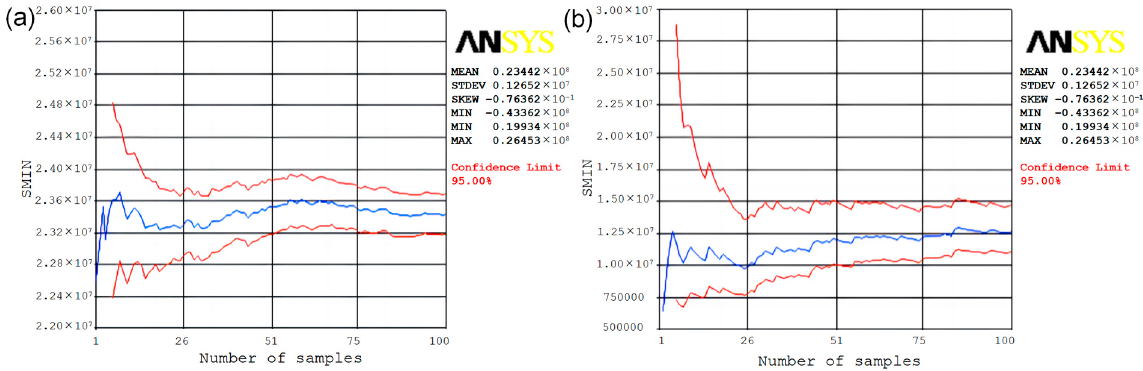
Figure 5. Sample of means and standard deviations of the random output variable SMIN: ( a ) mean values of samples; ( b ) standard deviation of sample.